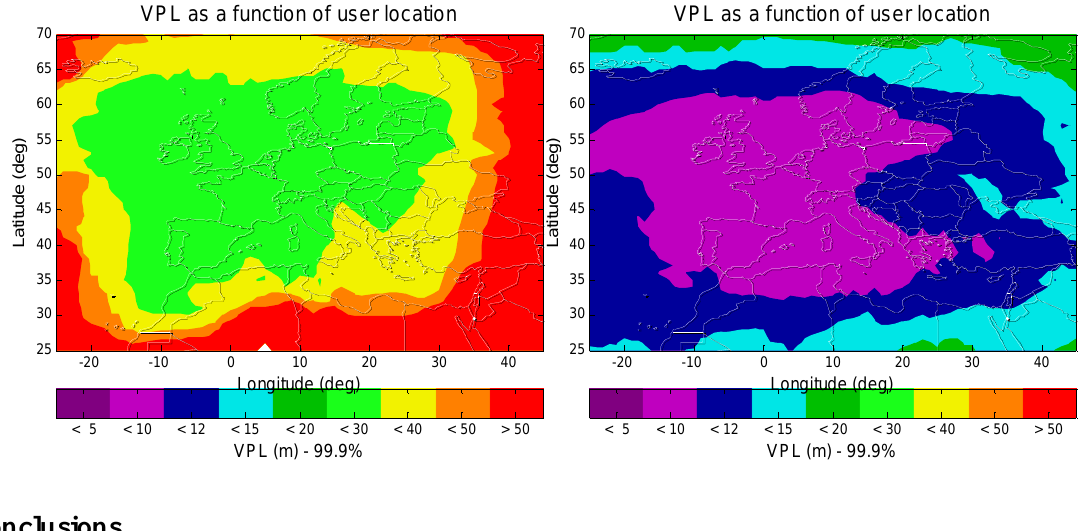
Figure 13. The 99.9% VPL contours of the EGNOS user avionics sensor. The left figure is for the current EGNOS user avionics sensor, and the right figure is for an L1-L5 dual-frequency EGNOS avionics sensor with GPS and